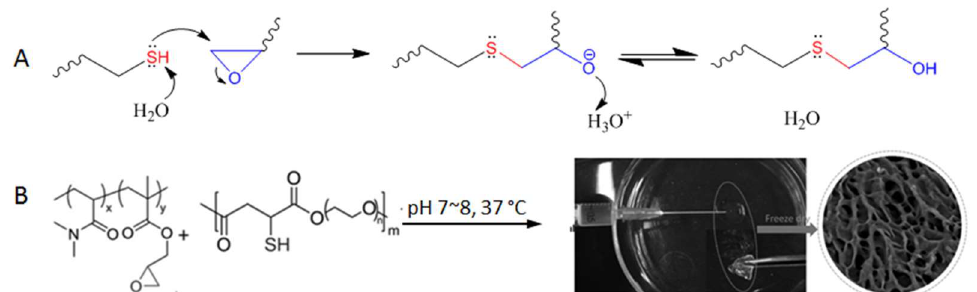
Figure 13. ( A ) Thiol-triggered ring opening of epoxides undergoes a nucleophilic substitution mechanism but does not produce byproducts. ( B ) The thiol-epoxy reaction for the crosslinking of polymers to form injectable hydrogel. Image modified with permission from [61] . Copyright 2016